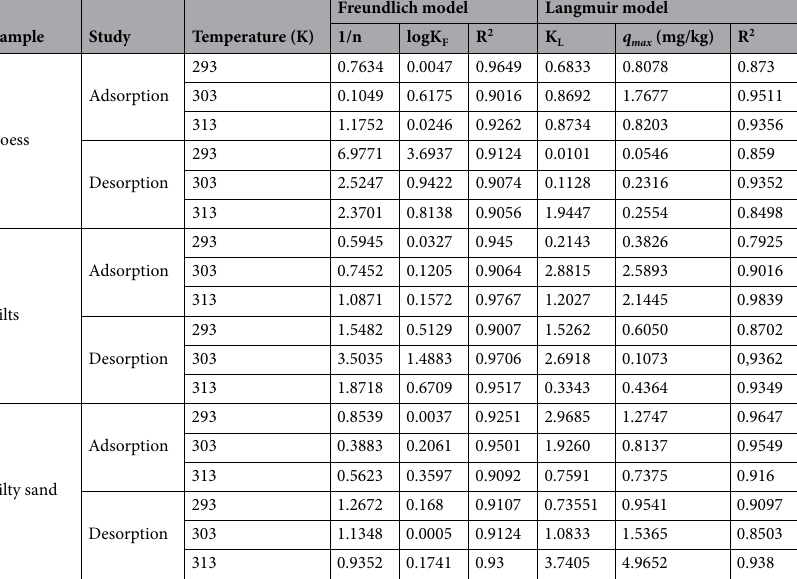
Table 4. Isotherm parameters for Phenanthrene sorption in soils.